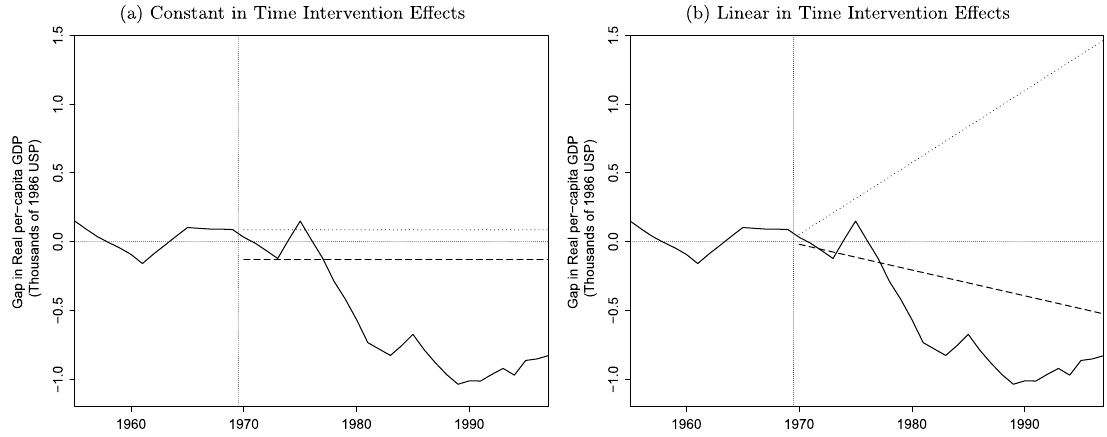
Figure 3: One-sided 12 / 14 -Confidence Sets for the Intervention Effect. Note: The solid black lines show the estimated im- pact of ETA’s terrorism on the Basque Country’s economy while the dashed lines show the upper-bounds of the one-sided 12 / 14 -Confidence Sets for Constant in Time or Linear in Time (with intercept equal to zero) Intervention Effects that were con- α post / ( T − T 0 ) and using the equal weights benchmark (equation (5) ). The dotted lines are the structed using the test statistic θ = − ̂ σ / √ T − T 0 upper bounds of the one-sided 12 / 14 -Confidence Sets that were constructed using the test statistic θ and imposing a sensitivity parameter ϕ = 0 . 495 for the worst case scenario described in section